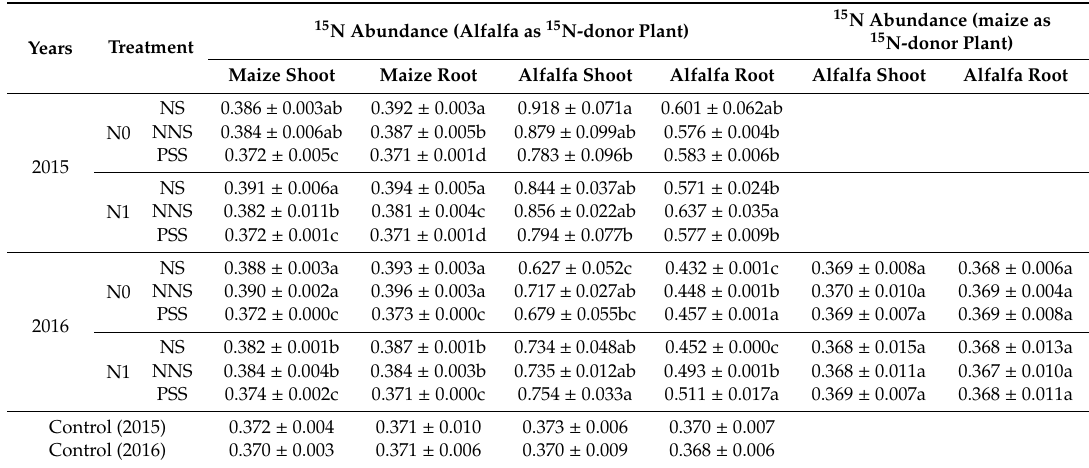
Table 4. 15 N abundance (%) in shoots and roots of maize and alfalfa under di ff erent conditions. Years